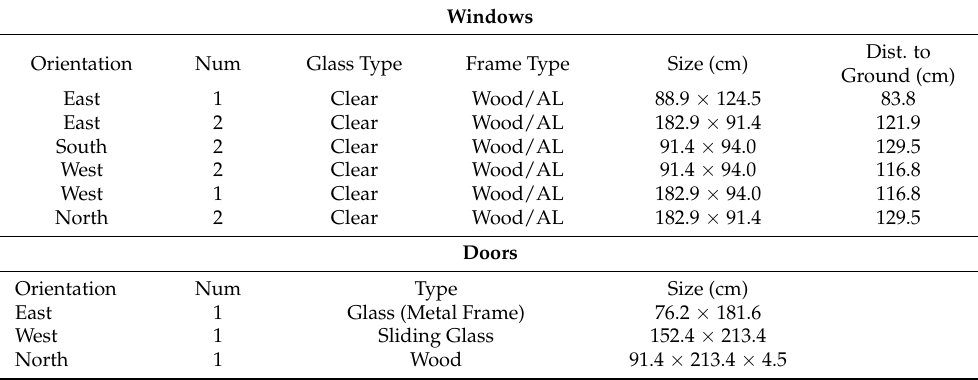
Table 1. Windows and doors data.